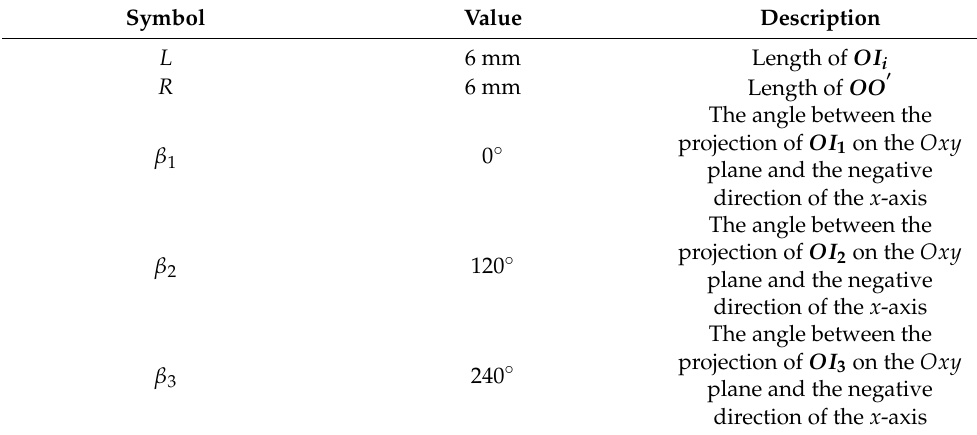
Table 1. Parameters of the